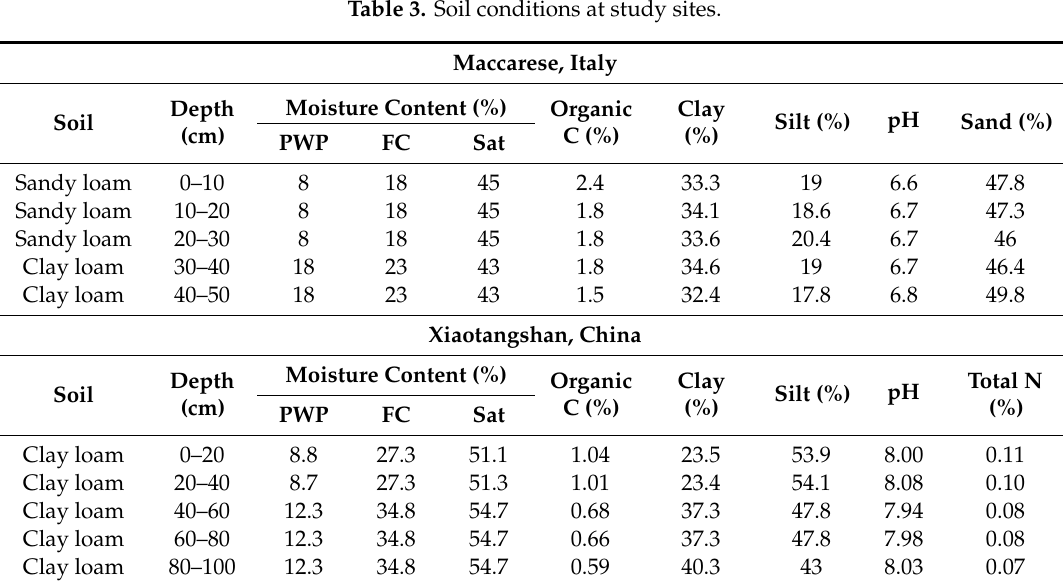
Table 3. Soil conditions at study